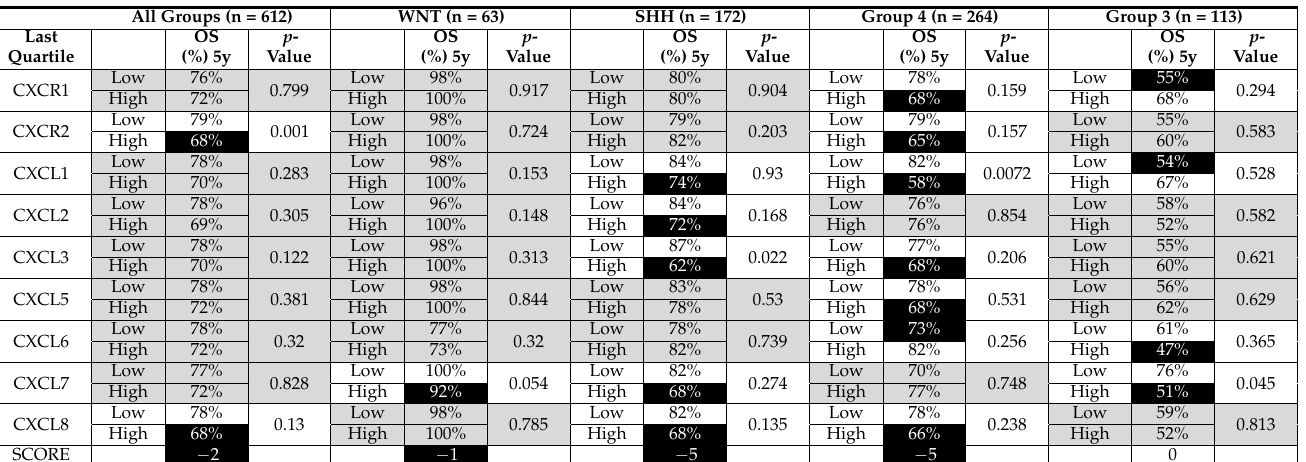
Table 2. ELR+CXCL/CXCR expression in patients in relation to prognosis. Summary table showing 5-year overall survival (OS) as a function of ELR+CXCL/CXCR mRNA expression in the different subgroups of MB patients. The last lane is an arbitrary grading of the prognosis of the MB patients according to their CXCL and CXCR expression (positive trend = +1, negative trend = − 1; cases coloured in black, if the difference between OS is less than 10% = 0; cases coloured in grey). A negative score corresponds to a poor prognosis, a positive score is associated with a good prognosis. This analysis was done with the software R2 in the Cavalli database, cut off = last